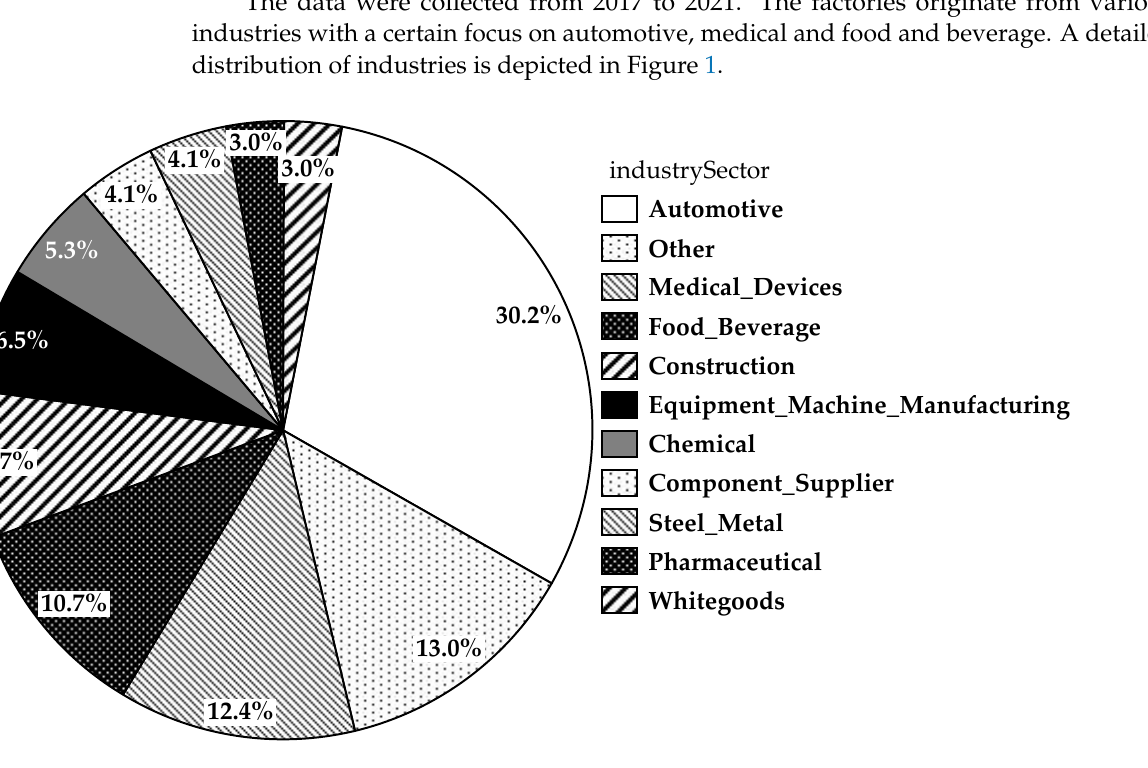
Figure 1. Distribution of industries .